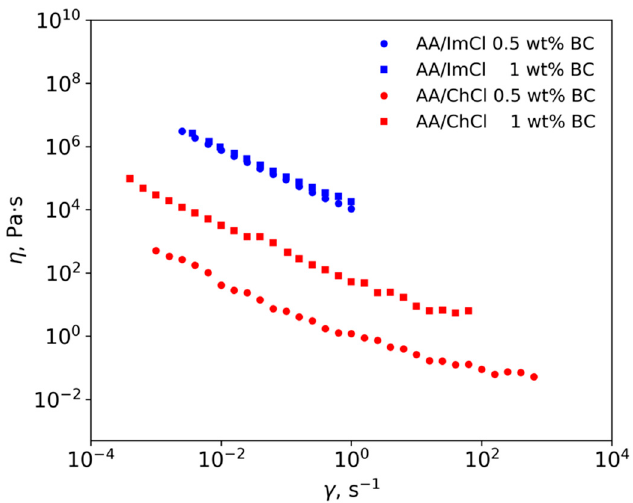
Figure 8. Steady-state viscosity ( η ) of the different compositions as a function of shear rate ( γ ) at 20 °C. 20 ◦